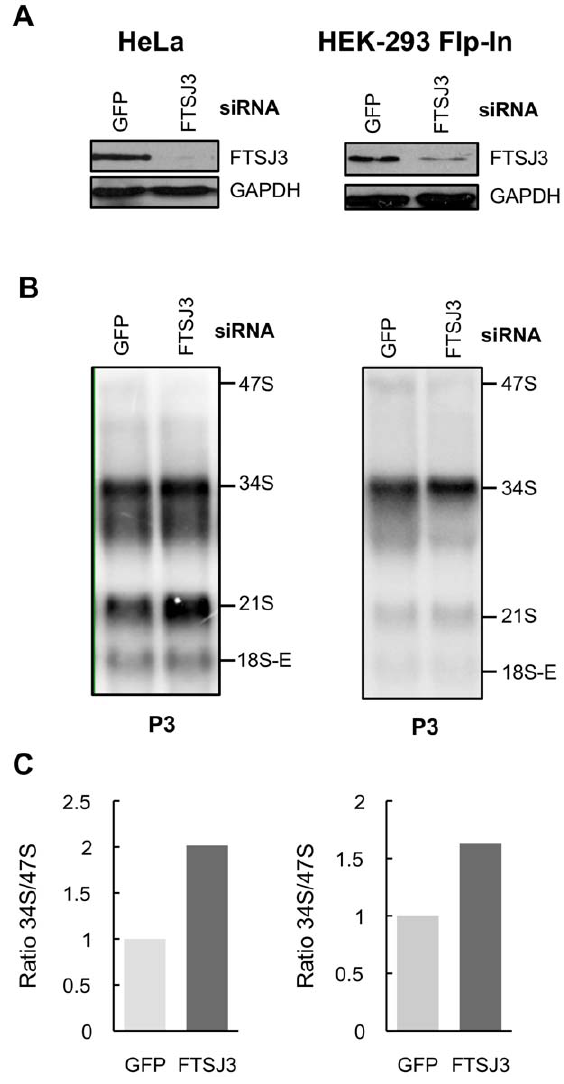
Figure 7. Analysis of pre-rRNAs intermediates in HeLa and HEK293 Flp-In T-Rex cells transiently transfected with a siRNA targeting the FTSJ3 mRNA. ( A ) Western blot analysis to determine FTSJ3 levels 72 h following siRNA transfection. ( B ) Northern blot using probe P3 complementary to ITS1 upstream site 2b. ( C ) Graphs representing the ratio between the 34S and 47S pre-rRNA of the Northern blots shown in B. Bands were quantified by using ImageQuant software. Control cells were transfected with siRNA targeting the GFP mRNA.